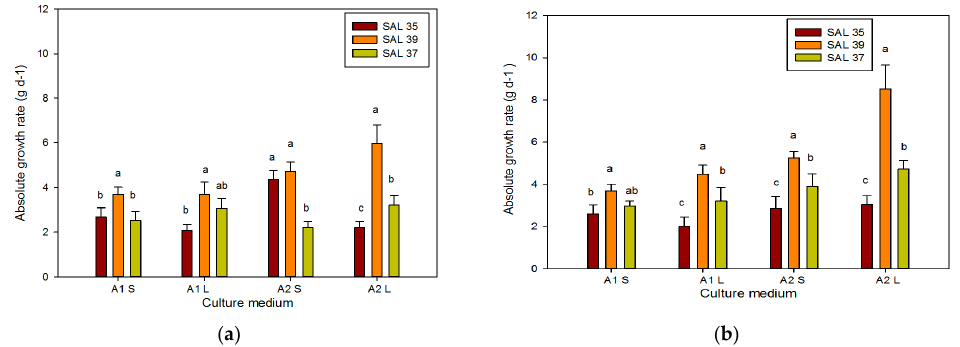
Figure 5. Absolute growth rate (AGR) of different C. spinosa accessions after 30 ( a ) and 60 days ( b ) in different culture systems. Bars represent standard error. The different letters reported above the bars grouped for each single treatment indicate statistically significant differences; n.s. not significant (Tukey’s test, p ≤ 0.05 ).